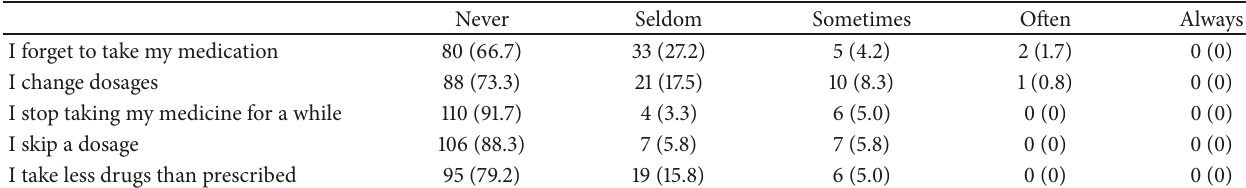
Table 2: Medication adherence report (MARS).